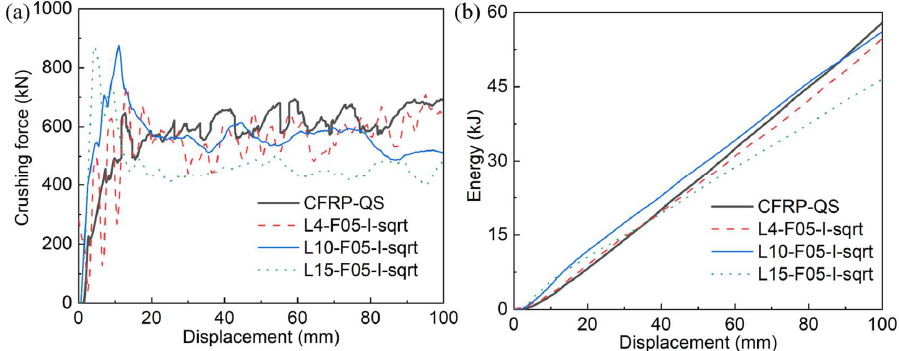
Figure 8. Comparisons of ( a ) crushing force–displacement curves and ( b ) energy–displacement curves between experimental (CFRP-QS) and simulated results with shell layers of 4, 10, and 15.